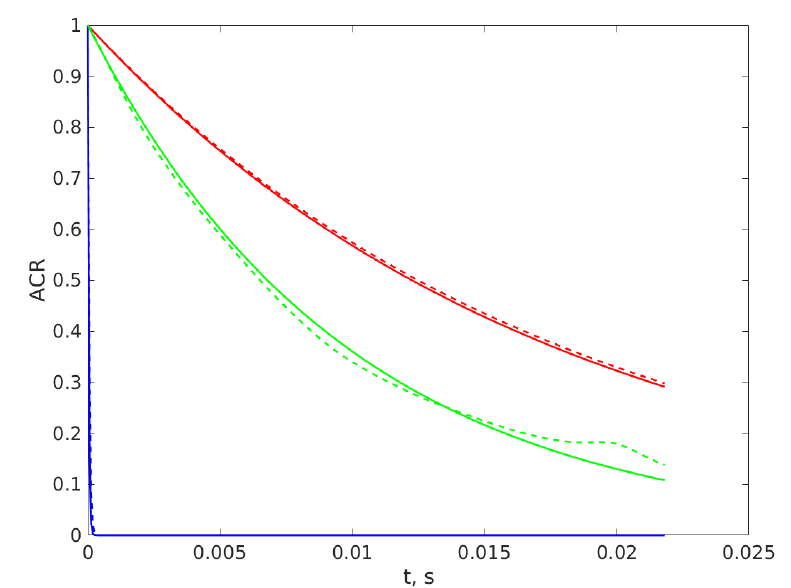
Figure 2. The autocorrelation (ACR) computed on time series generated without noise with Equation (7) for diameters of 10 nm, the continuous lower (blue) line; 15 nm, the lower dashed (blue) line; for 5100 nm, the continuous upper (red) line; and 5200 nm, the upper dashed (red) line. The ACRs for a diameter of 2858 nm computed with Equation (5) are presented with the continuous middle (green) line; and with noise added, Equations (10) and (11), with the dashed middle (green) line.